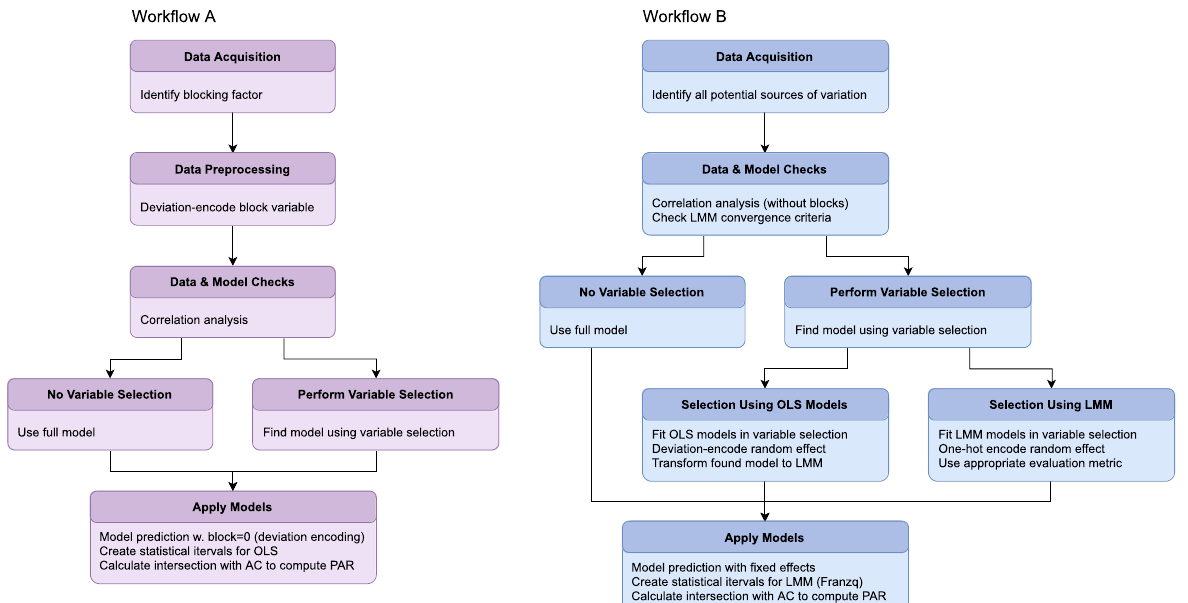
Fig. 7 Workflows for creating control strategies based on regression models. The left column describes an approach that uses OLS models for the estimation of PARs. A mixed-model-based workflow is summarized on the right. The differences in the steps involved are subtle but generally result in a more realistic estimation of variance and therefore a more robust control